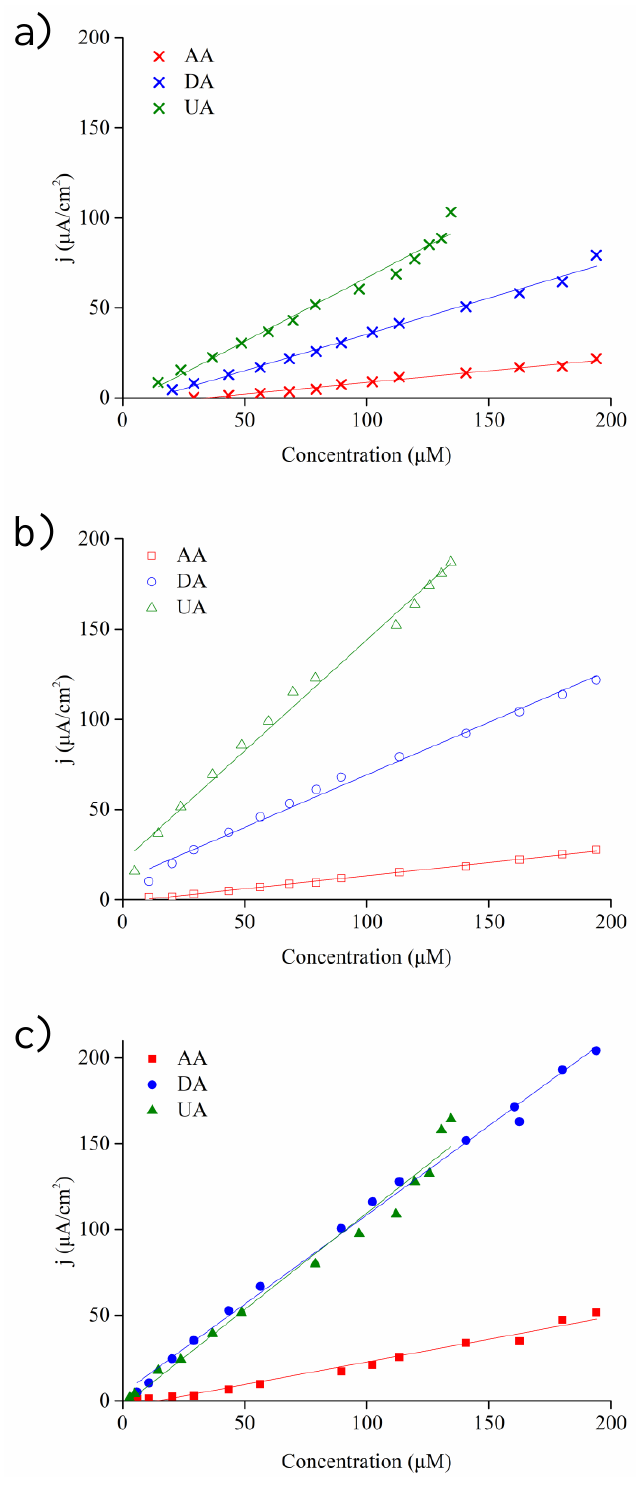
Figure 10. The linear relations of anodic current (after the subtraction of capacitive current) as a function of the concentration of AA, DA, and UA for ( a ) planar Ni@PEDOT film, as well as ( b ) Ni@PEDOT and ( c ) Ni@PEDOT/Au inverse opals, respectively.